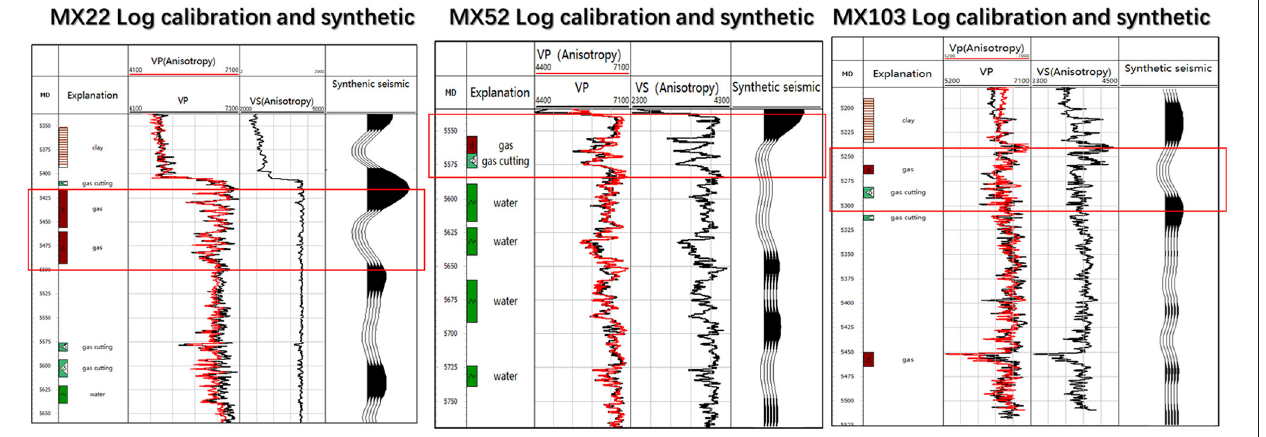
FIGURE 5 | Log calibration and synthetic seismic data.